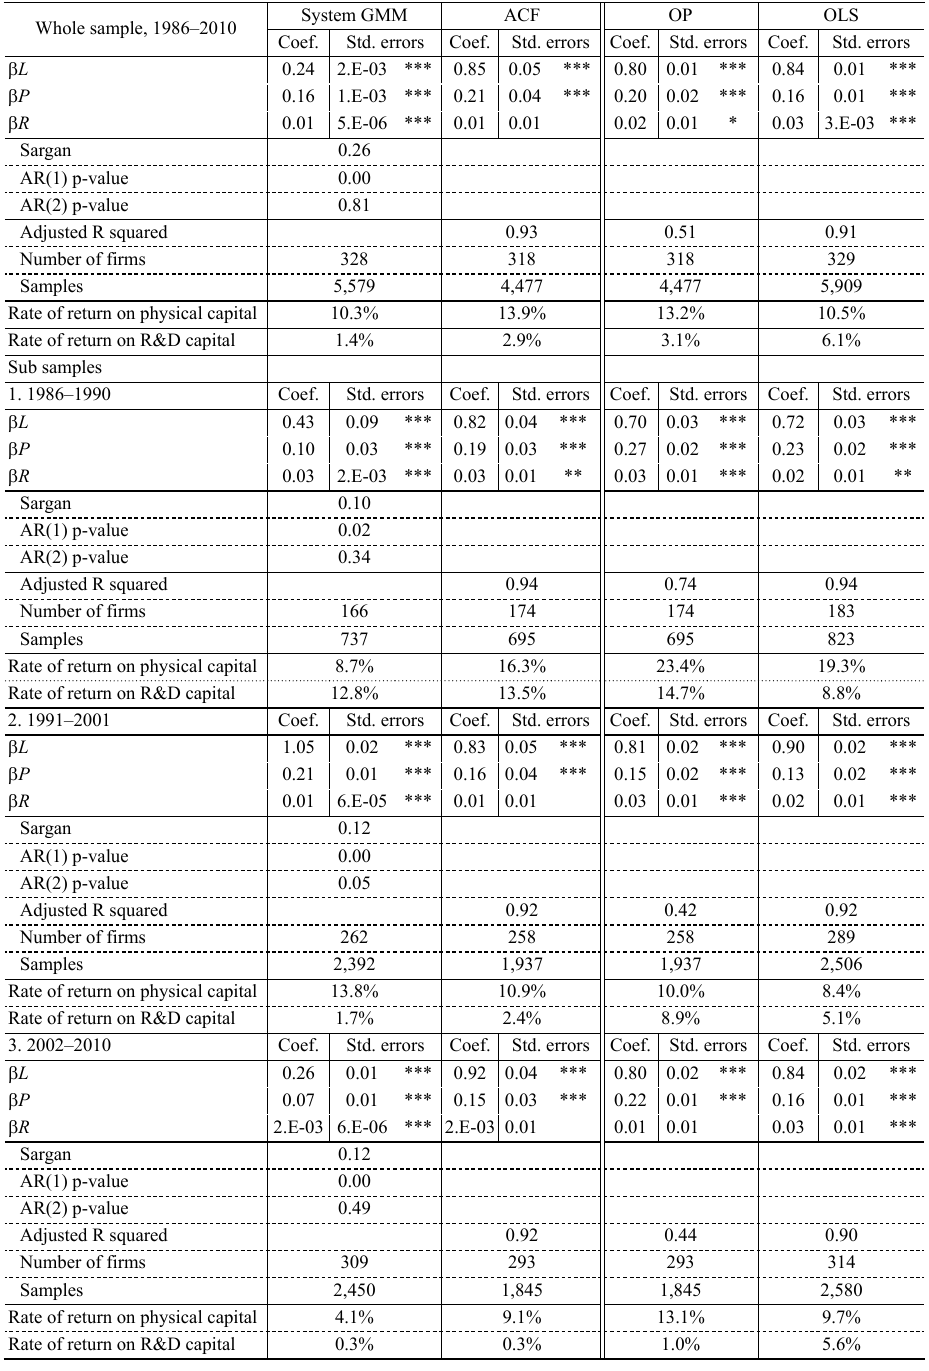
Table 7. Comparison of results from the four estimation methods for machinery firms Whole sample,